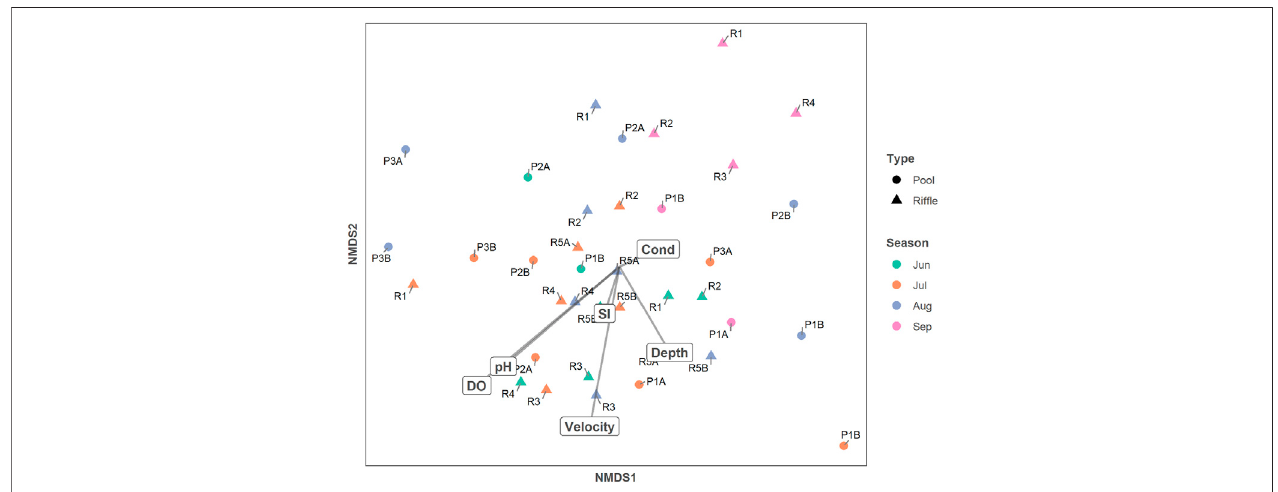
FIGURE 9 | Non-metric Multi-Dimensional Scaling (NMDS) Plot depicting pairwise dissimilarities in BMI community composition for samples collected in rif fl es (triangles)andpools(circles)inJune(green),July(orange),August(blue),andSeptember(pink).Dissimilarityincreaseswithdistancebetweensamples.Theaxesandthe orientation of the plot are arbitrary. Straight dark lines are vectors for dissolved oxygen (DO), pH, substrate index (SI), velocity, depth, and electrical conductivity (Cond).